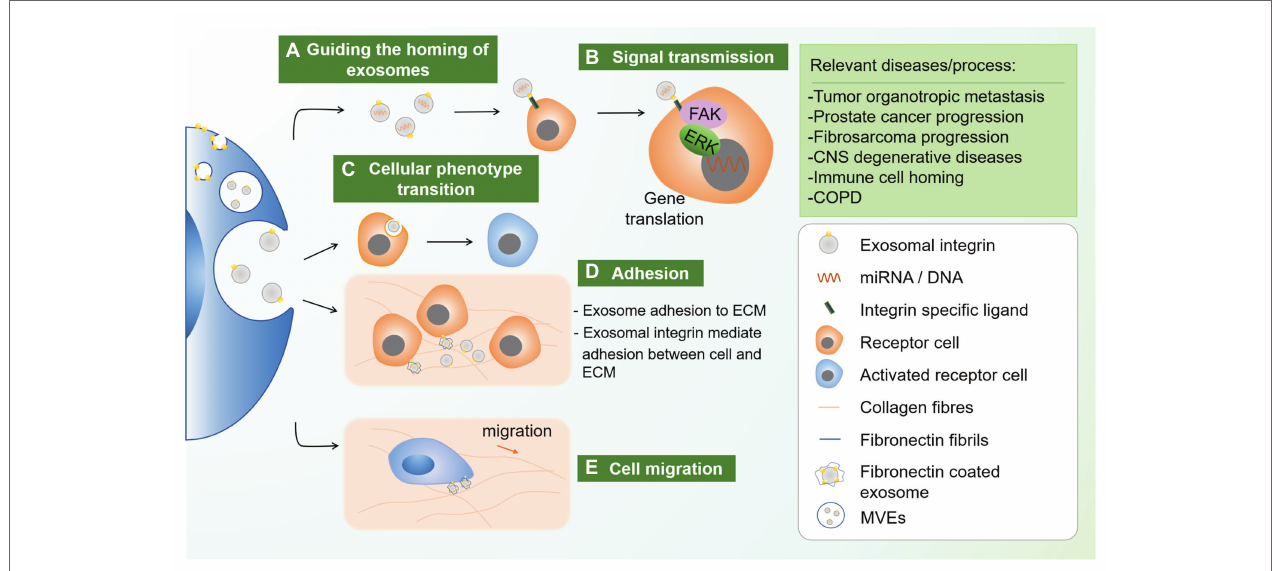
FIGURE 1 | Novel functions of exosomal integrin. Exosomal integrin played diverse roles in different disease conditions including guiding the homing of exosomes, signal transmission, cellular phenotype transition, and cellular adhesion and migration. (a) Exosome cargoes such as miRNA and protein can be delivered to neigbor and distant cells, while specific type of exosomal integrin can guide the vesicles to specific cells through integrin-ligand recognition. (b) Integrin-ligand interatction could activate intracellular signals, for example FAK and ERK-1/2, which initiate relevant gene translation. (c) Apart from intracellular signaling, endocytosis of specific exosomal integrin could also cause cellular phenotype transition of the receipient cells. (d) Exosomal integrin mediated exosome adhesion to extracellular matrix (ECM) through integrin-ECM binding. (e) Moreover, ECM, for example, fibronectin, could be coated on exosome through a process involving endocytosis of integrin α v β 1-fibronectin complex which then sorted into MVEs. FN-coated exosomes secreted and bind to collagen fibrils, which can then coupled to cellular integrin receptors. This adhesion ensures the stable adhesion to ECM during migration. CNS, central nervous system; COPD, chronic obstructive pulmonary diseases; MVEs, multivesicular